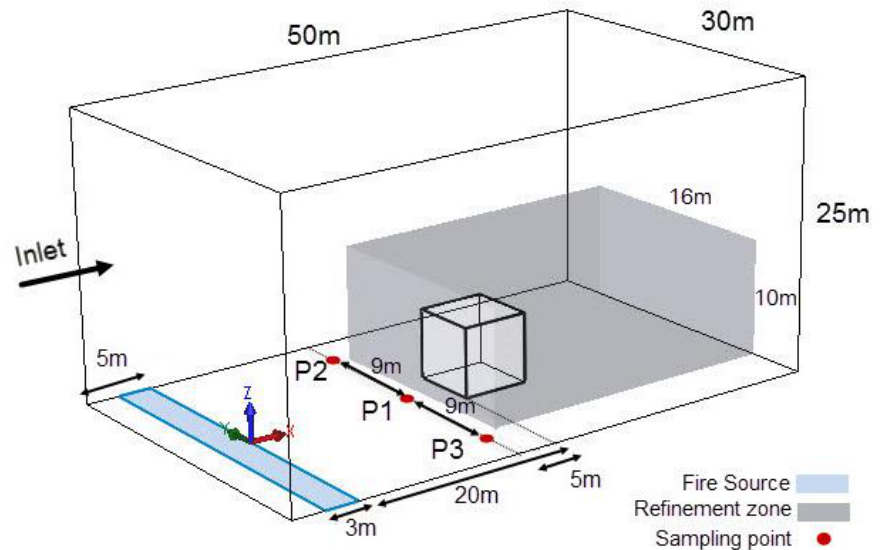
Figure 1. Schematic of the computational domain and the location of the refinement zone (shaded with grey colour) and temperature monitoring points.